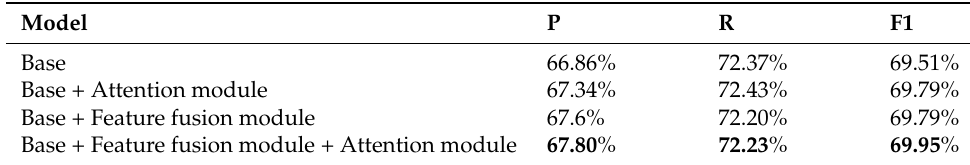
Table 10. Ablation experiments for each module on the KBP37